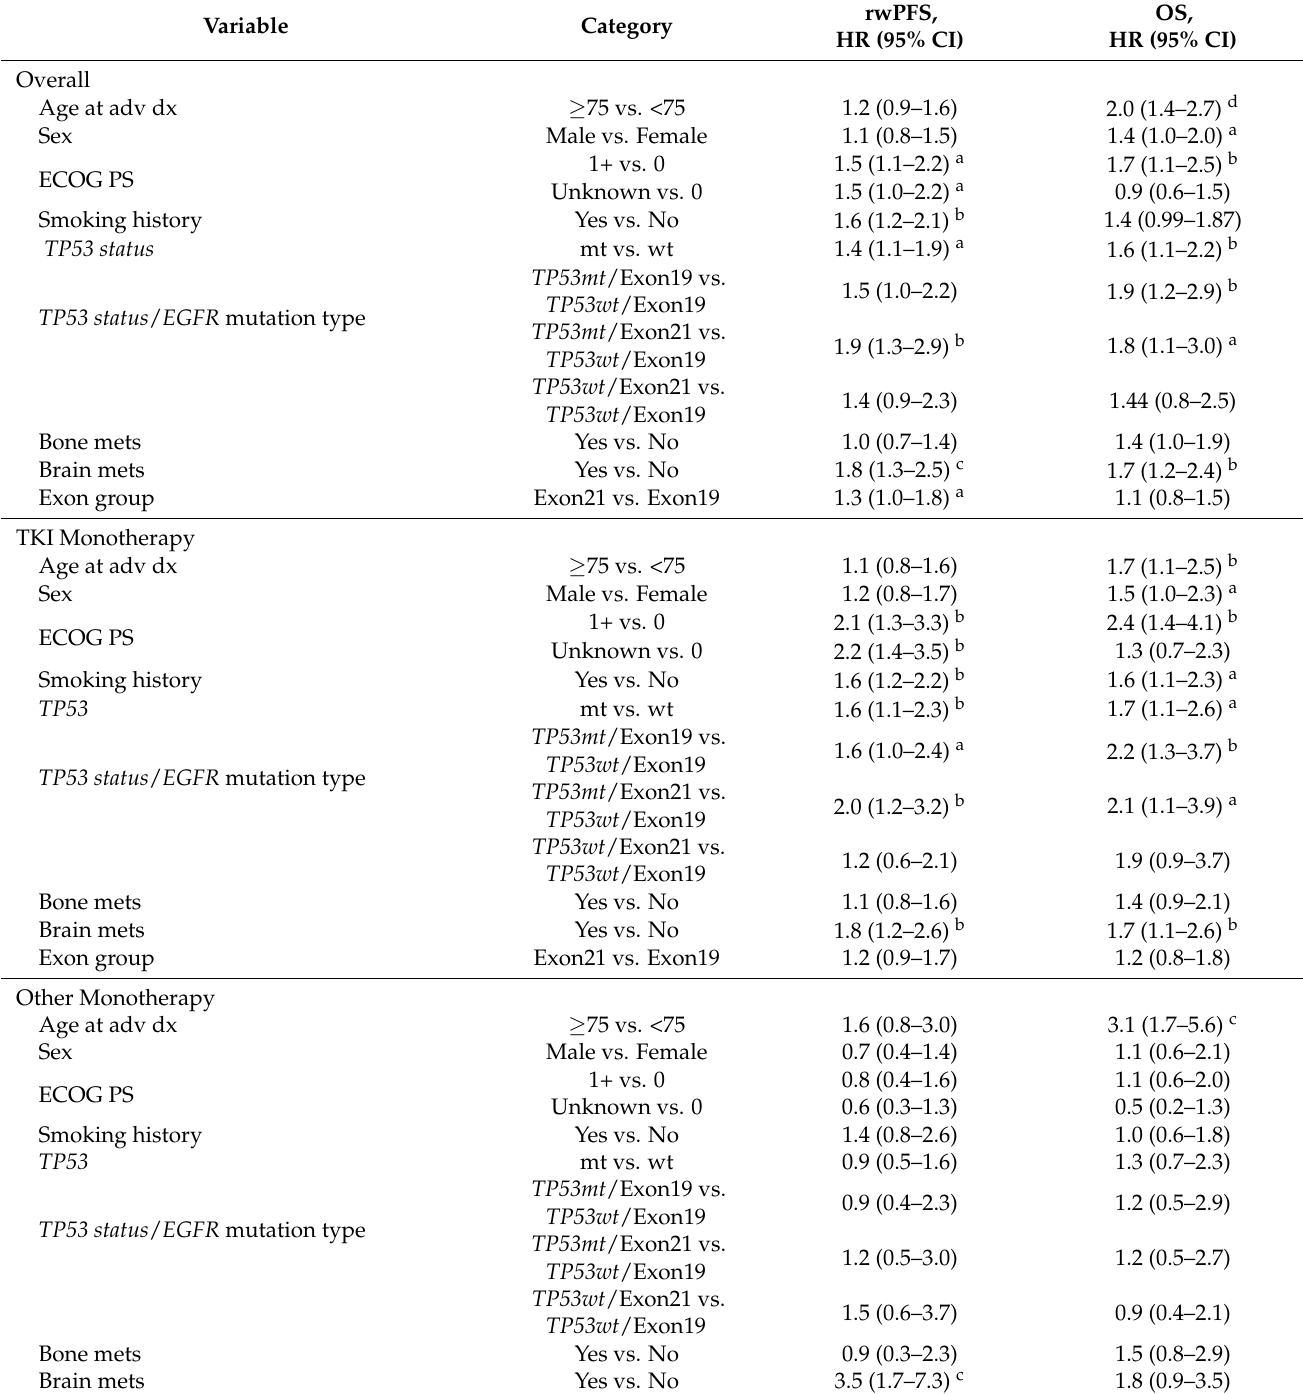
Table 3. Univariate analysis—rwPFS and